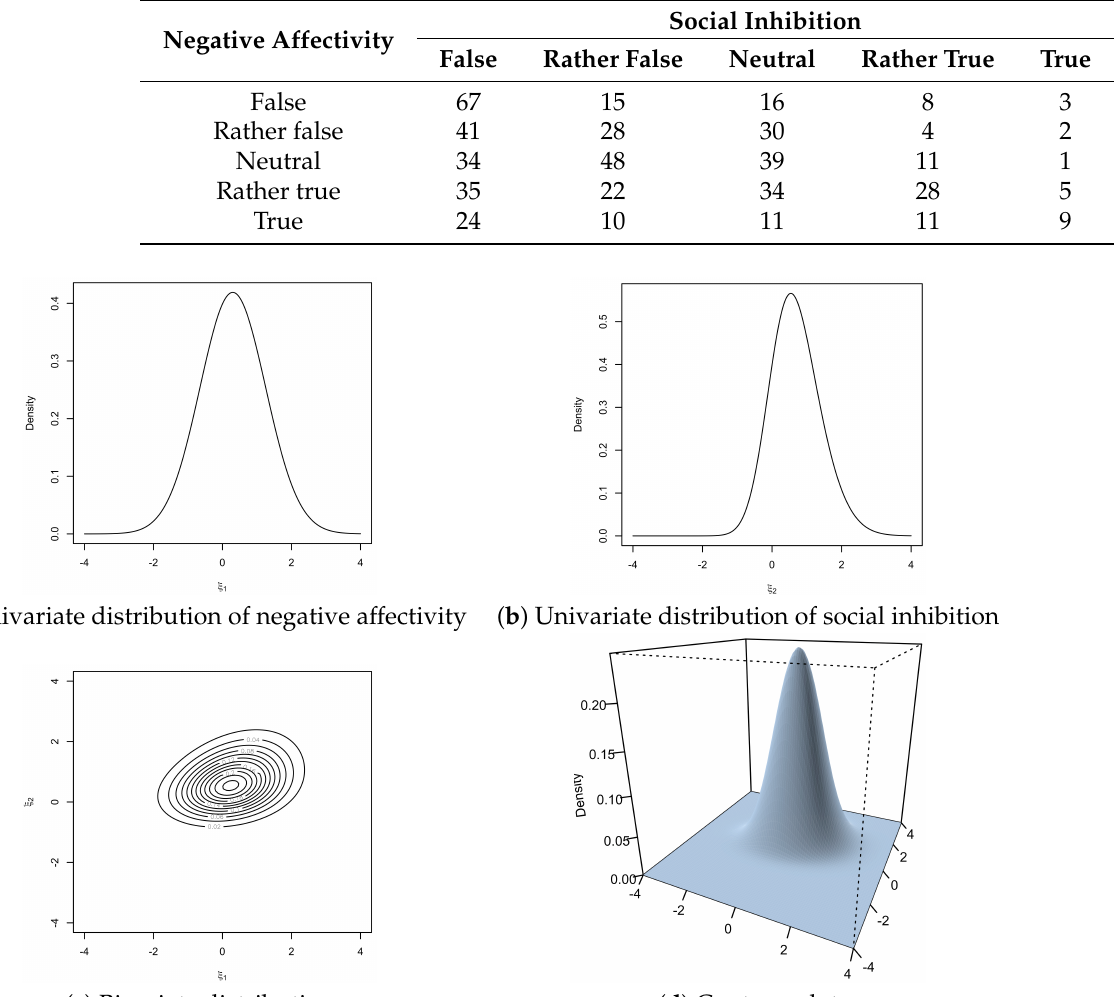
Table 1. Contingency table for the Type D personality data.